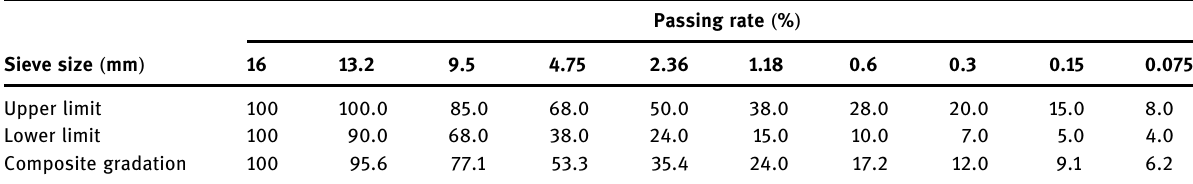
Table 3: Aggregate gradation of the AC - 13C asphalt mixture